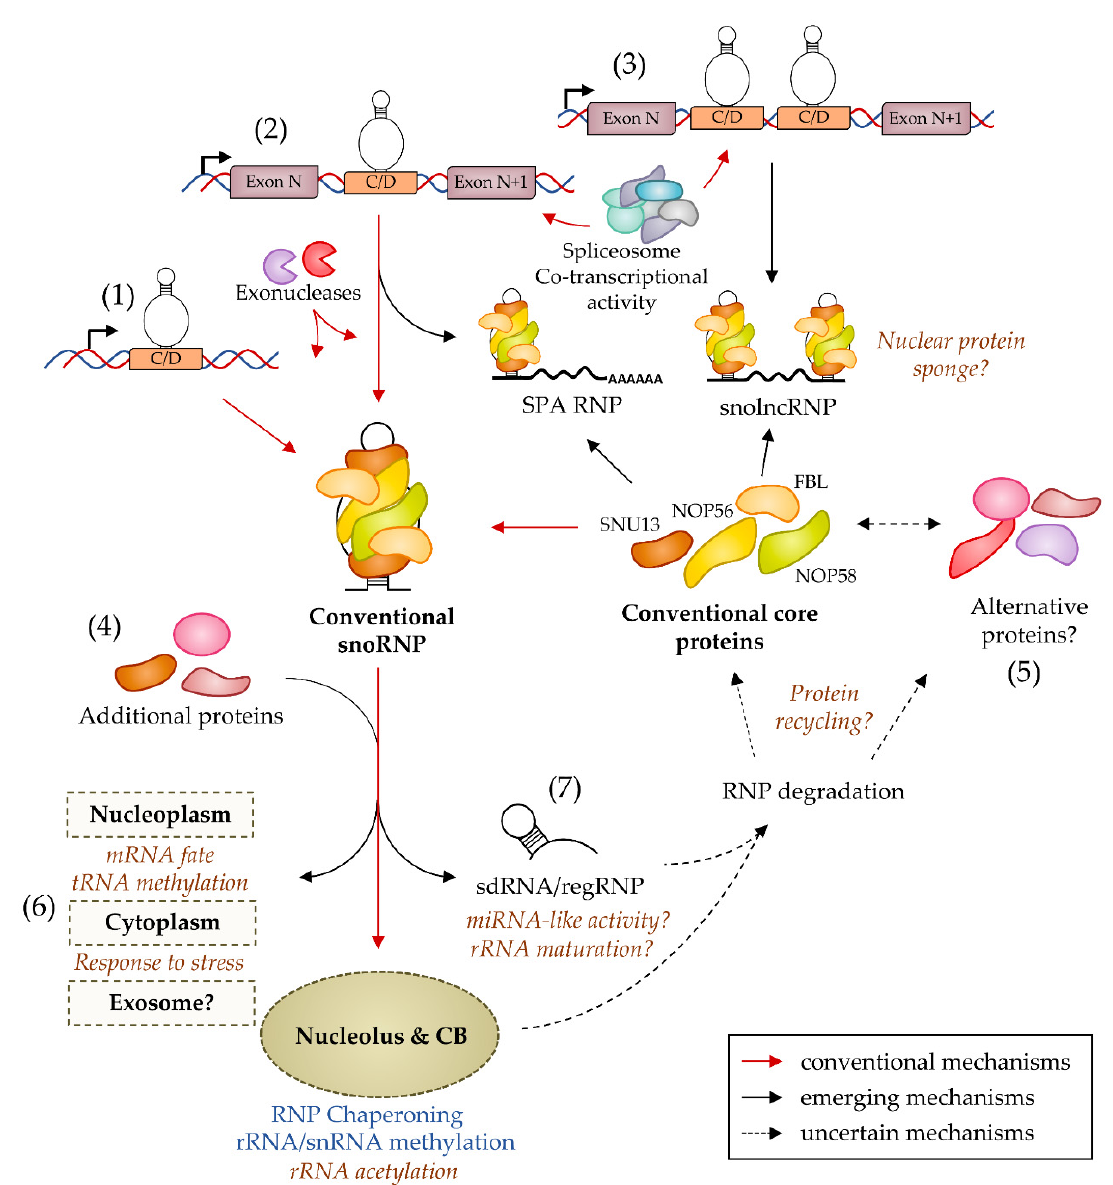
Figure 3. The emerging diversity of C/D box snoRNA processing and of C/D snoRNP biogenesis and function. Precursor C/D box snoRNAs are produced by both independent ( 1 ) and intronic ( 2 and 3 ) genes, then processed by the combined action of intron lariat debranching in the case of intronic snoRNAs and exonucleotidic activities acting at both the 5 (cid:48) and 3 (cid:48) ends. Co-transcriptional recruitment of snoRNP core proteins on the snoRNA allows the correct processing and biogenesis of the C/D snoRNP. Then, the particle reaches the Cajal body (CB) and the nucleolus to perform activities on snRNAs and rRNAs (in blue). In addition to these conventional mechanisms, C/D snoRNPs perform new activities (in gold italics) linked to the formation of lncRNAs flanked by snoRNA sequences at one or both ends generated from partially-processed, snoRNA-hosting introns ( 3 ), to the recruitment of additional proteins conferring new properties and/or enzymatic activities ( 4 ) or to the exchange of conventional core proteins by alternative proteins ( 5 ), to the trafficking to new subcellular locations ( 6 ), and to the generation of snoRNA-derived fragments (sdRNAs) or regulatory ribonucleoproteins (regRNPs; 7 ).